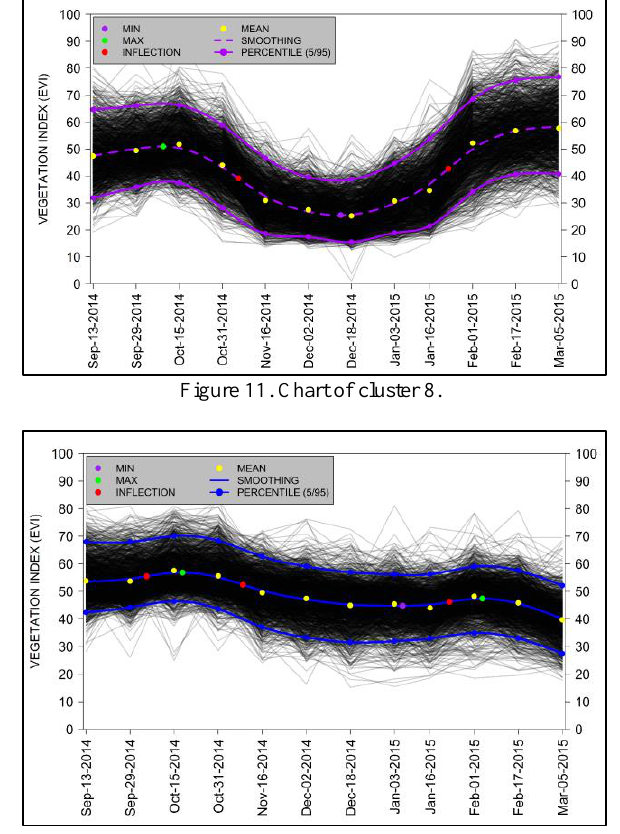
Figure 12. Chart of cluster 7.